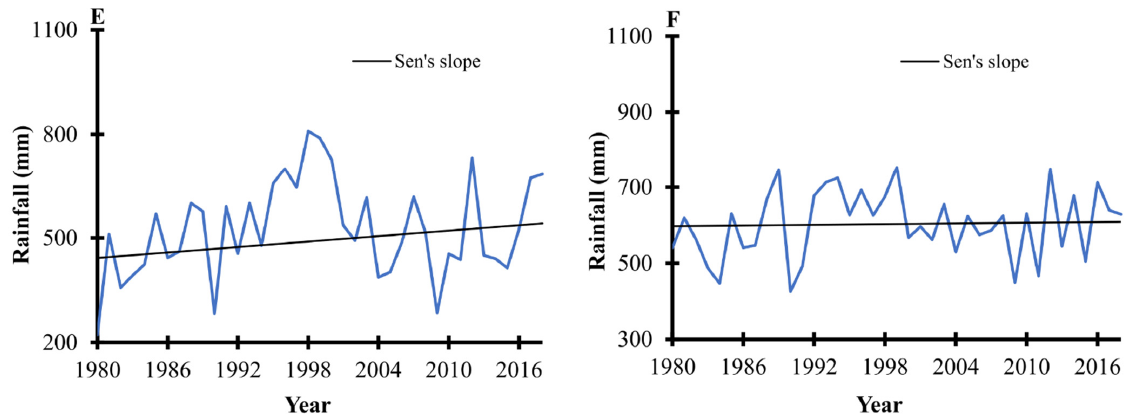
Figure 4. Annual rainfall trends in five locations in Gedaref state, Sudan between 1980 and 2018. ( A ): Gedaref, ( B ): El gadabalea, ( C ): Am Senat, ( D ): Samsam, ( E ): El hawata, and ( F ): Average rainfall for all five locations.